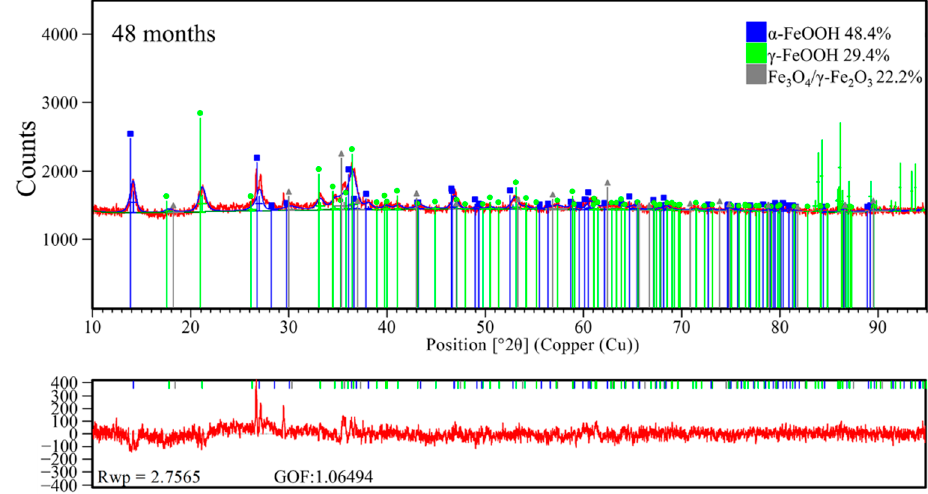
Appl. Sci. 2023 , 13 , x FOR PEER REVIEW Figure 11. Full spectrum fitting analysis. Figure 11. Full spectrum fitting analysis.